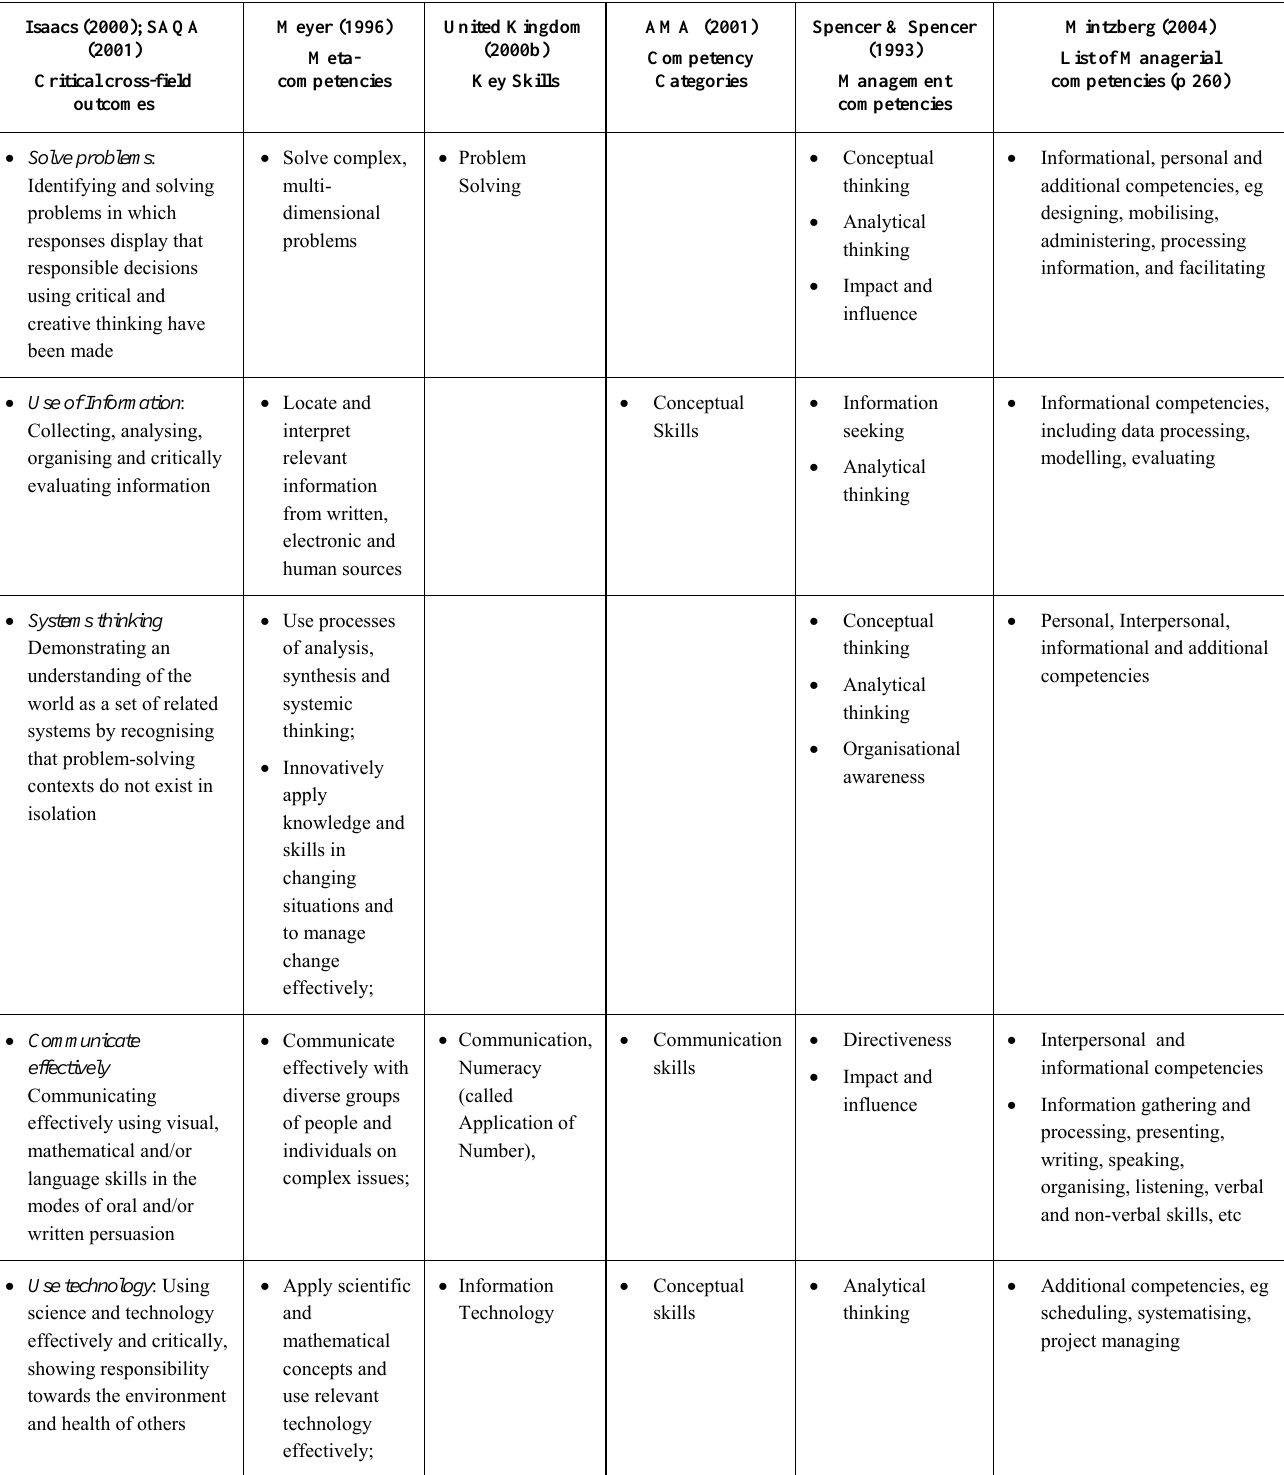
Table 1: An illustrative matrix of assessable generic meta-competencies Isaacs (2000); SAQA (2001) Critical cross-field